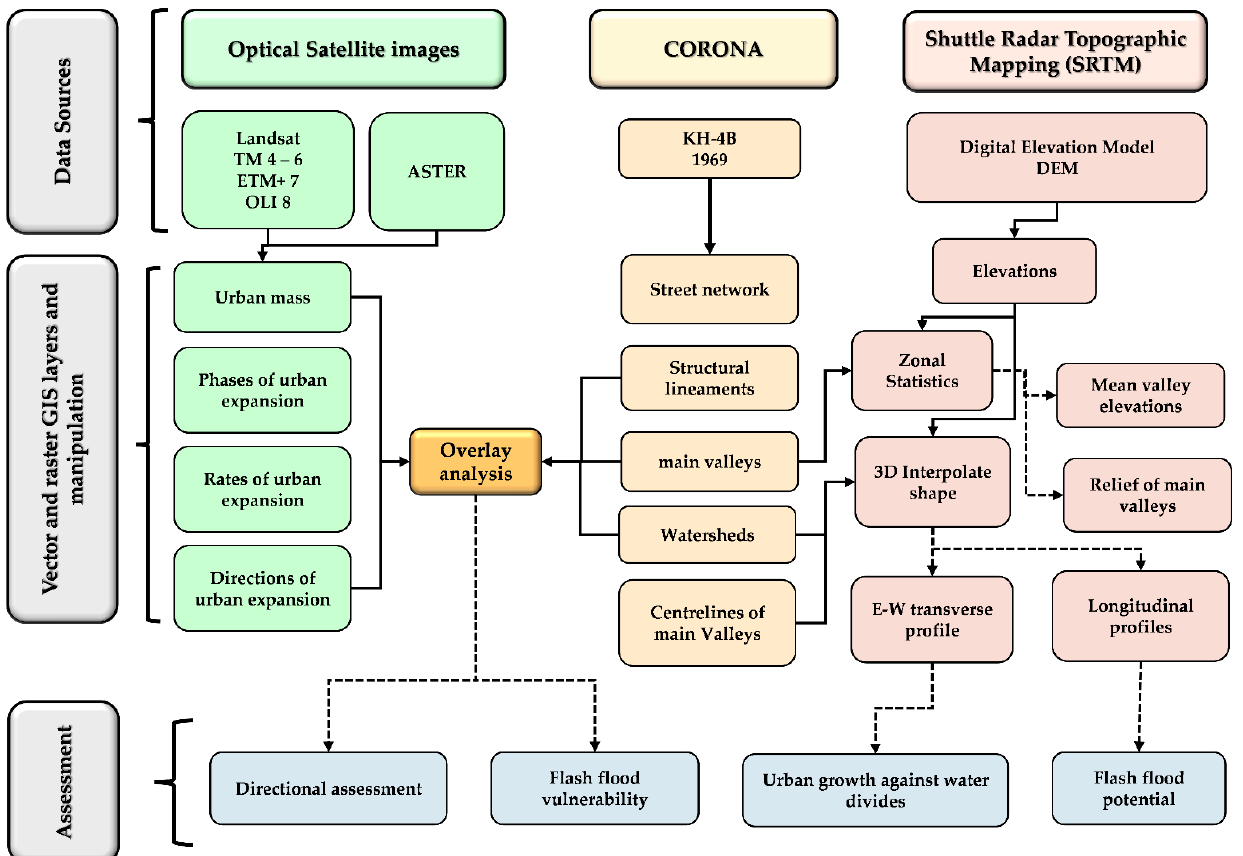
Figure 3. Flow chart of the research methodology.